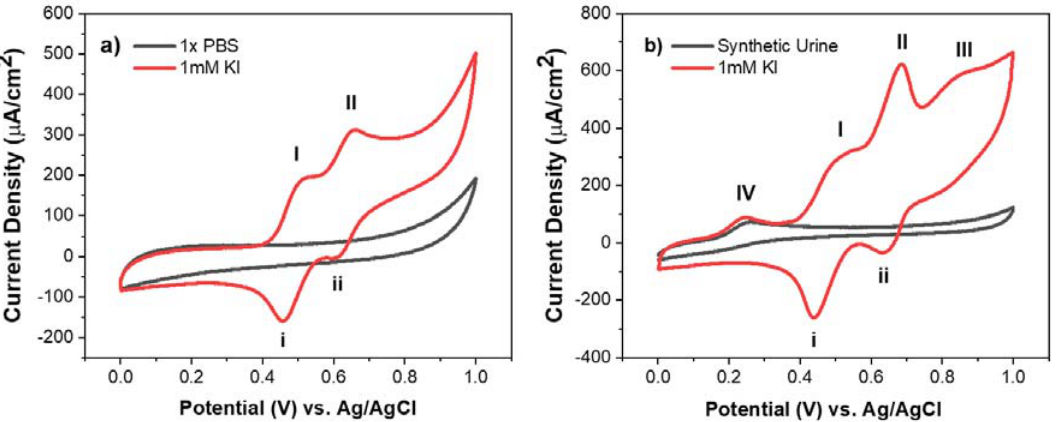
Figure 3. Cyclic voltammograms of 1 mM potassium iodide in ( a ) 1X PBS and ( b ) synthetic urine with a scan rate of 5 mV/s. The two-redox reactions of iodide ions are shown as (I)/(II) and (i)/(ii), respectively in both 1X PBS and synthetic urine. The additional peaks are observed in ( b ) attributed to the oxidation of unknown species occurring in the presence of potassium iodide (III) or the oxidation of creatinine in synthetic urine (IV).